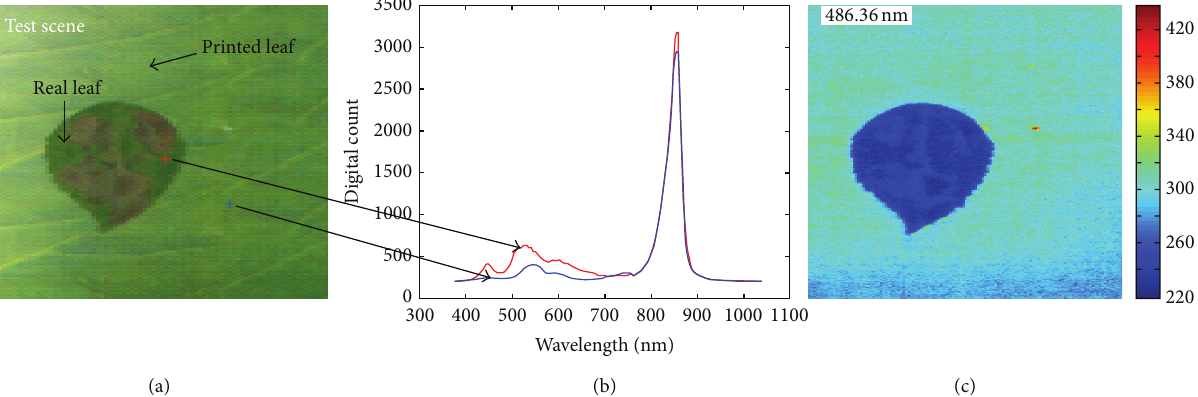
Figure 3: Spectral analysis: (a) test hypercube, (b) spectral profiles at the selected points, and (c) band image at 486.36